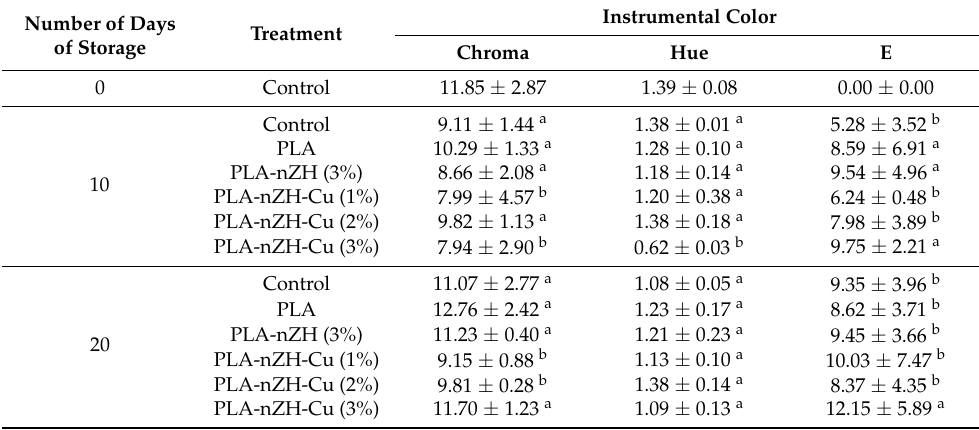
Values are presented as mean ± SD. N = 3. Values followed by different superscript letters in the same column indicate significant